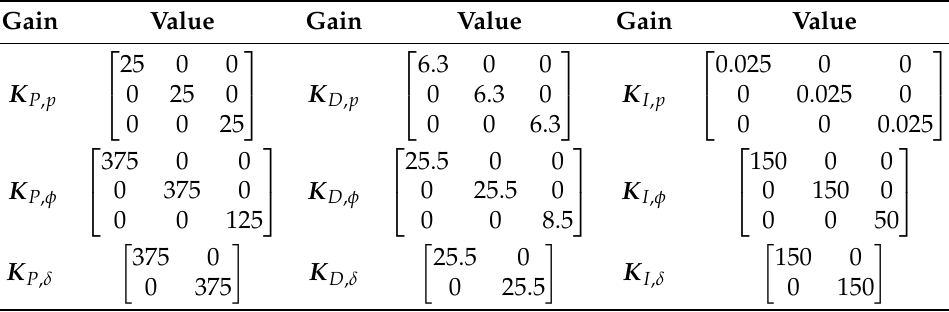
Table 1. Gain matrices for the auxiliary inputs (19), (20) and (27).